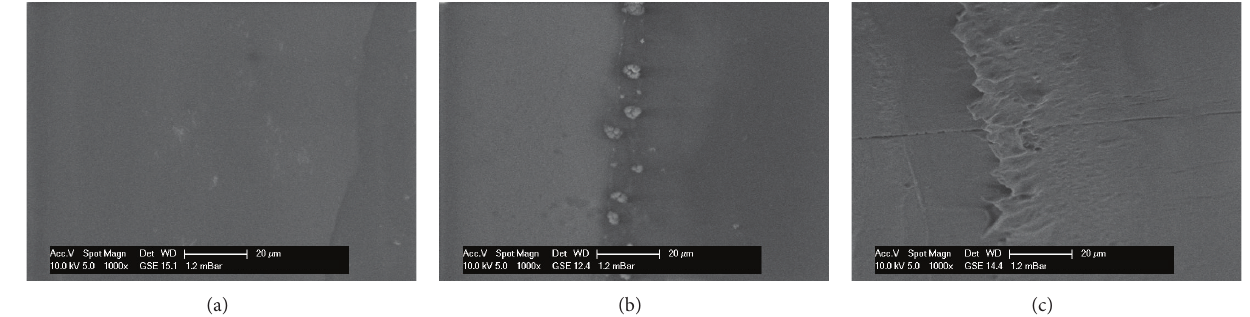
Figure 4: Representative ESEM micrographs of HA base layer coupled to (a) unmodified, (b) APTES-modified, and (c) GPTMS-modified PA12 surfaces. For better visualization of the coating, the coating boundary was put into focus. Attachment of HA to unmodified surfaces was performed according to conditions for GPTMS-modified surfaces.